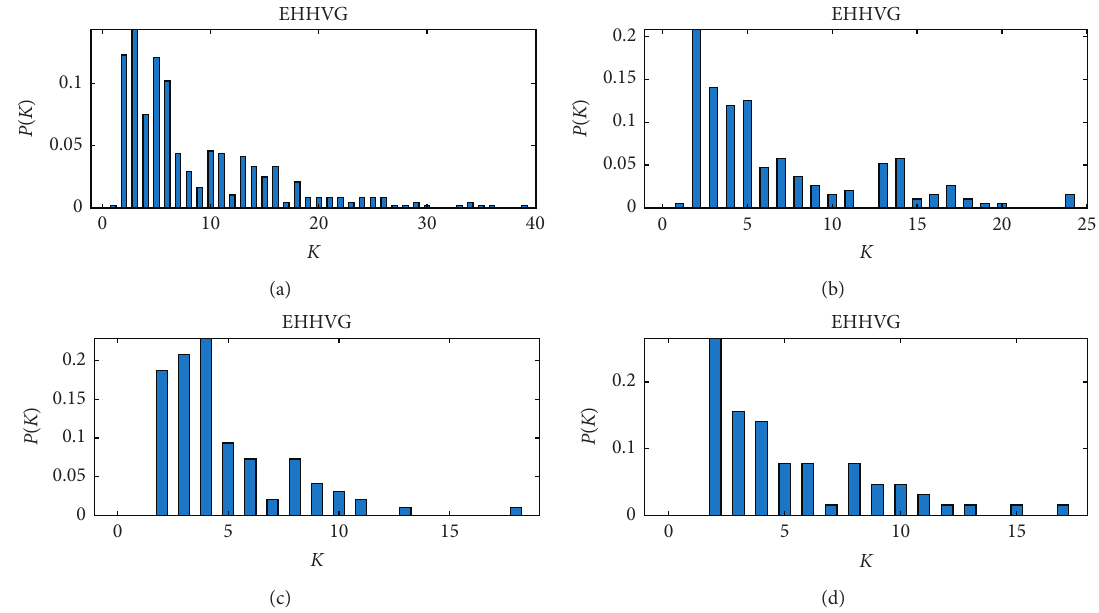
Figure 15: Degree distribution of visual graph and horizontal visual graph. (a) Δ t � 2min. (b) Δ t � 5min. (c) Δ t � 10 min. (d) Δ t � 15min.